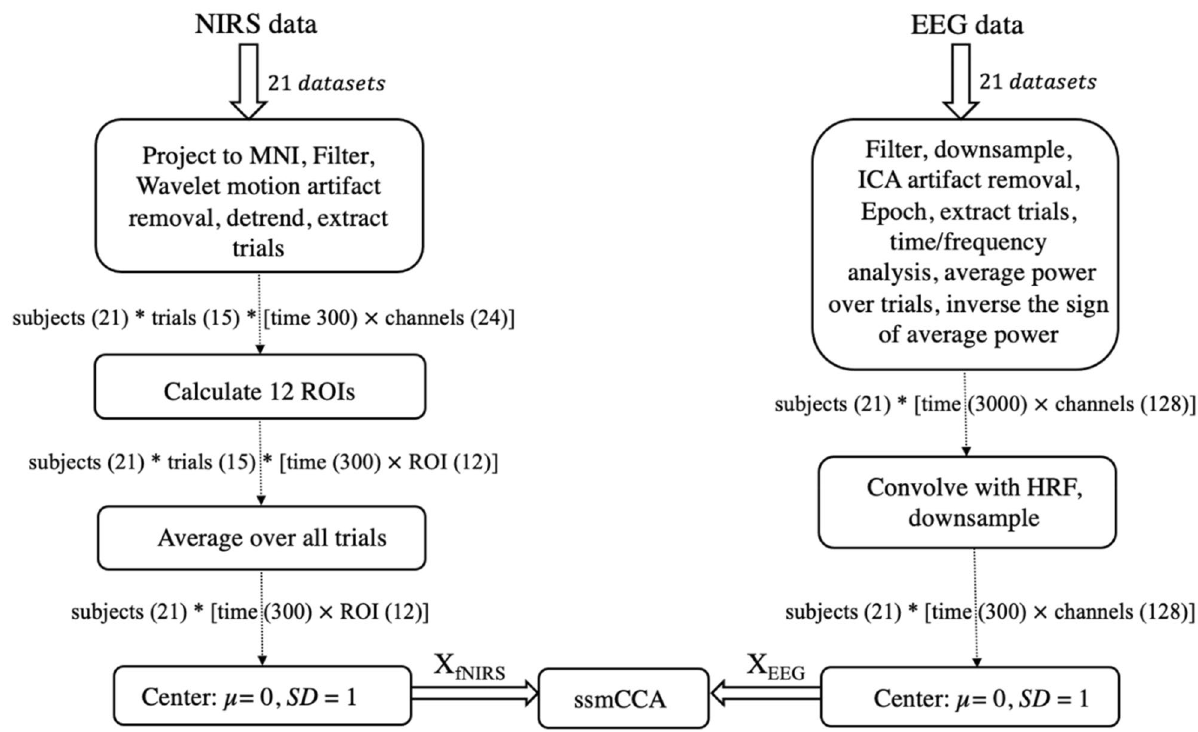
Figure 2. Preprocessing workflow for EEG and fNIRS datasets. After preprocessing, 42 datasets in total entered the ssmCCA algorithm.